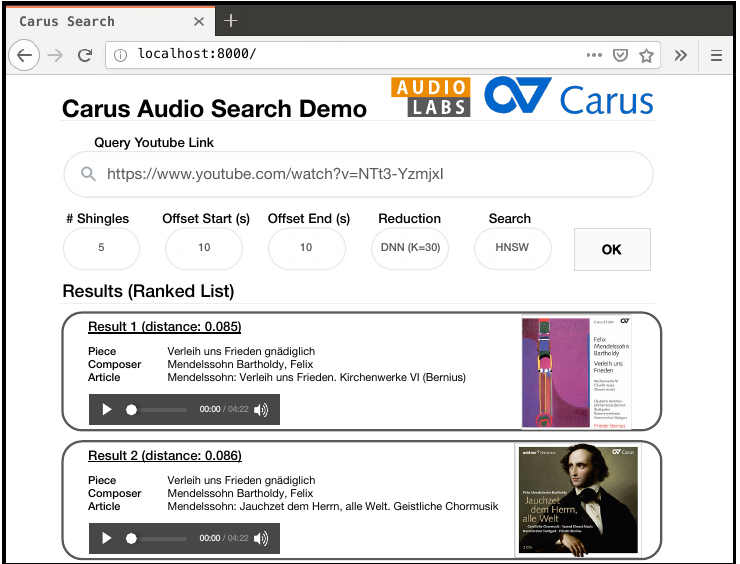
Figure 1. Illustrated screenshot of an internal version-retrieval web-interface for the Carus